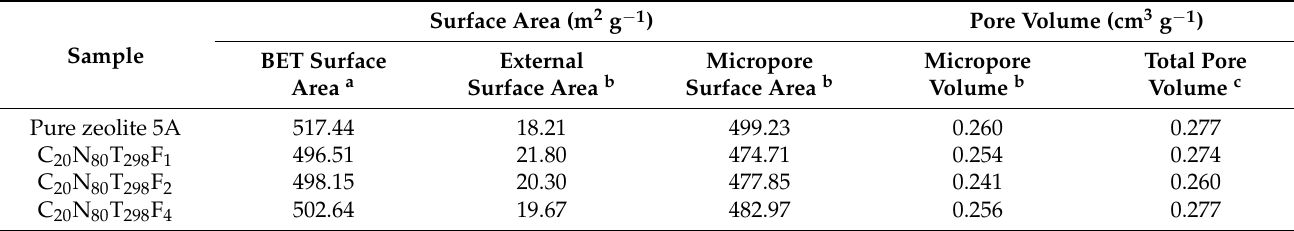
Table 2. The surface properties of pure zeolite 5A and after